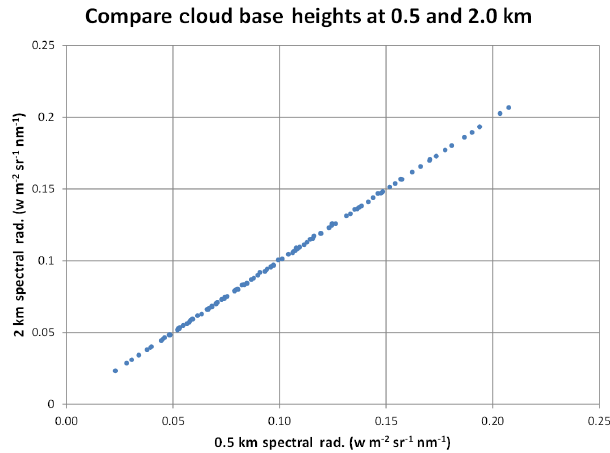
Figure 10. Scatterplot comparing 440nm radiance computed for cloud base heights of 500m and 2km, each varying over 10 COD and 11 solar zenith angles.